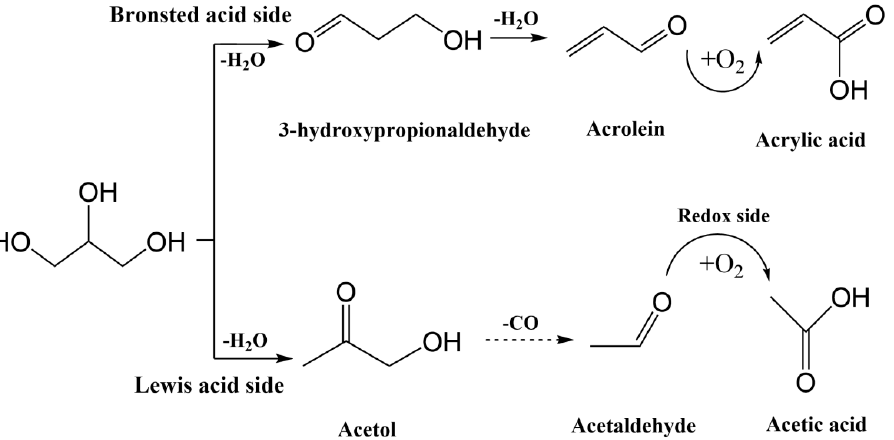
Figure 5. Proposed overall reaction pathways for glycerol dehydration representing the 1st and 2nd dehydration as well as tautomerization, according to the acrolein formation pathway.